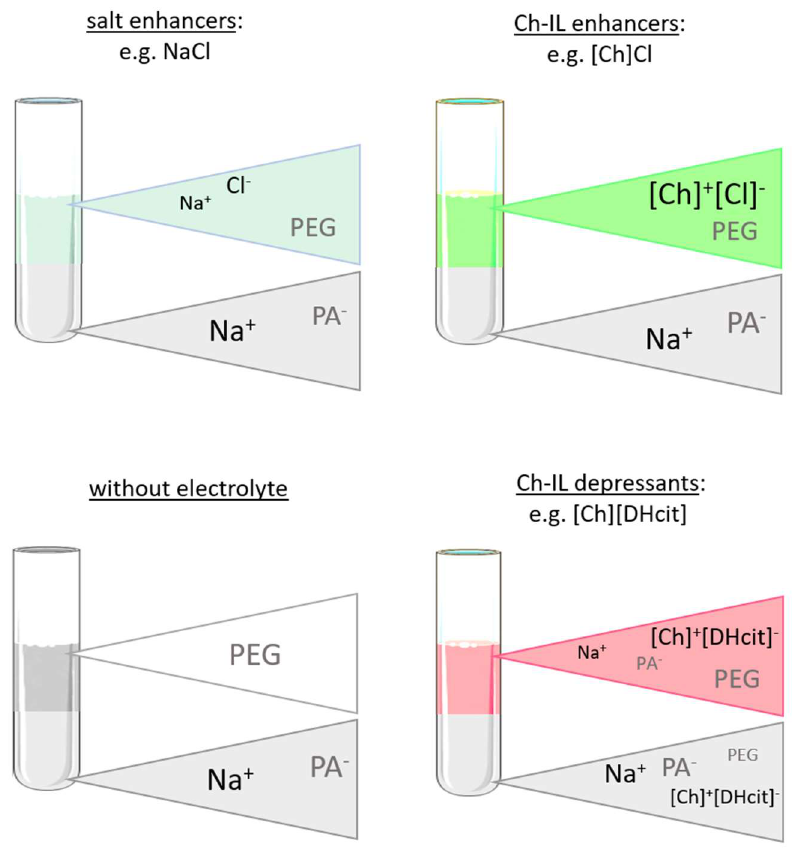
[Ch][Ac]) or ABS formation depressants ([Ch][DHcit] and [Ch][Bit). The intensity of these Figure 5. Schematic representation of partition coefficients of phase-forming components determined Figure 5. Schematic representation of partition coefficients of phase-forming components deter- peaks corresponding to each IL anion is in agreement with the IL partition coefficients for the systems composed of PEG 600 + NaPA 8000 + water + 10 wt% of electrolyte and without mined for the systems composed of PEG 600 + NaPA 8000 + water + 10 wt% of electrolyte and with- provided in Figures 3 and 4, determined by 1 H NMR and chloride ion-selective electrodes. electrolyte as a control, between the PEG-rich ( top ) phase and NaPA-rich ( bottom ) phase. out electrolyte as a control, between the PEG-rich (top) phase and NaPA-rich (bottom) phase. The logarithmic values of sodium cation’s partition coefficients [log ( Kp Na + )] (Figure 6) of NaCl/Na[Ac]-added ABS are less negative than those without any electrolyte added,